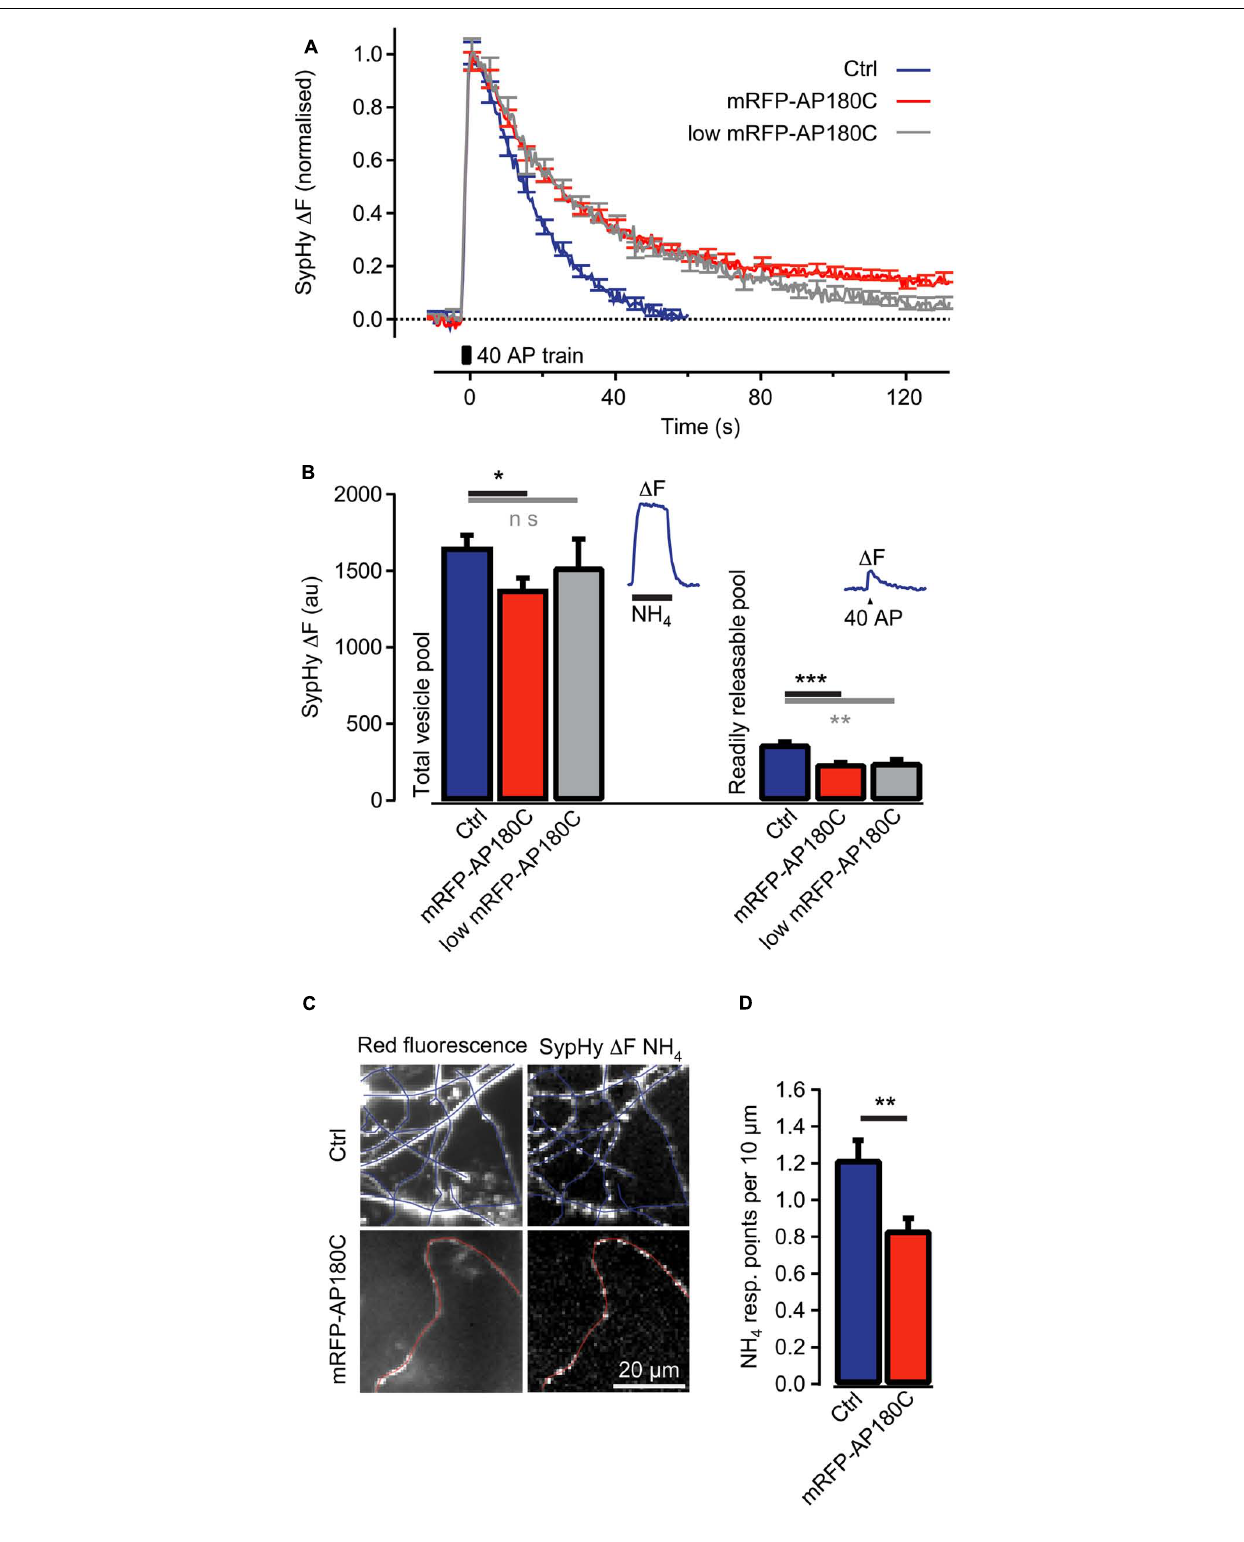
action potentials at 20 Hz (40 AP train). During the action potential train, the fluorescence intensity increased from exocytosis of